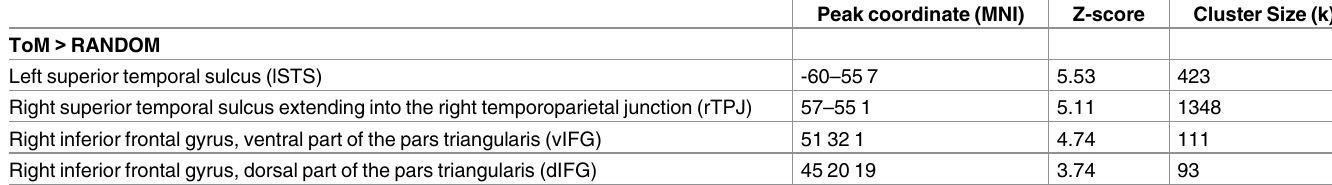
Table 2. MNI coordinates of peak activations during the localizer task associatedwith the contrastToM > RANDOM. Reportedclusters are significant at p < 0.05 (FWE corrected) after applyinga wholebrain uncorrected thresholdof p < 0.001 at voxel level.